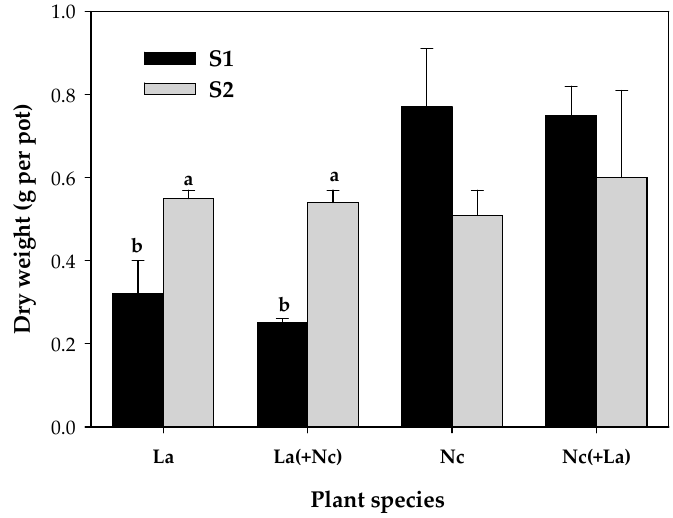
Figure 3. Plant dry weight in the different soils and treatments (g DW pot − 1 ± standard error). For each species, bars marked with different letters indicate significant differences at p < 0.05, according to Tukey’s test. La = L. albus ; Nc = N. caerulescens . Bars without letters indicate that no significant differences were found ( p > 0.05) between those samples.